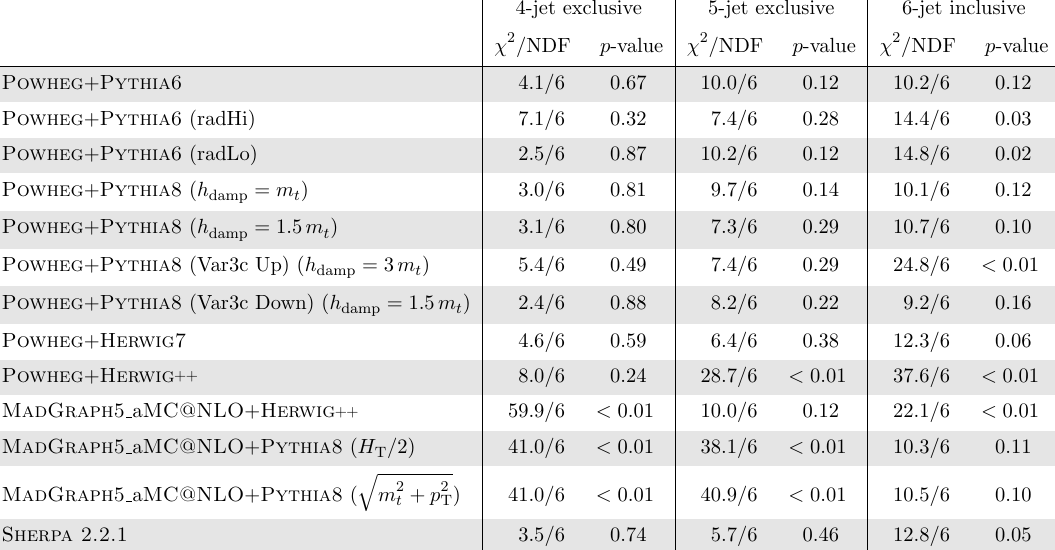
Table 7 . Comparison of the measured (cid:12)ducial phase space absolute di(cid:11)erential cross sections as (cid:12) (cid:12) (cid:12) (cid:12) a function of p t (cid:22) t and the predictions from several MC generators in di(cid:11)erent n -jet con(cid:12)gura- out (cid:12) (cid:12) tions. For each prediction a (cid:31) 2 and a p -value are calculated using the covariance matrix of the measured spectrum. The number of degrees of freedom (NDF) is equal to the number of bins in the